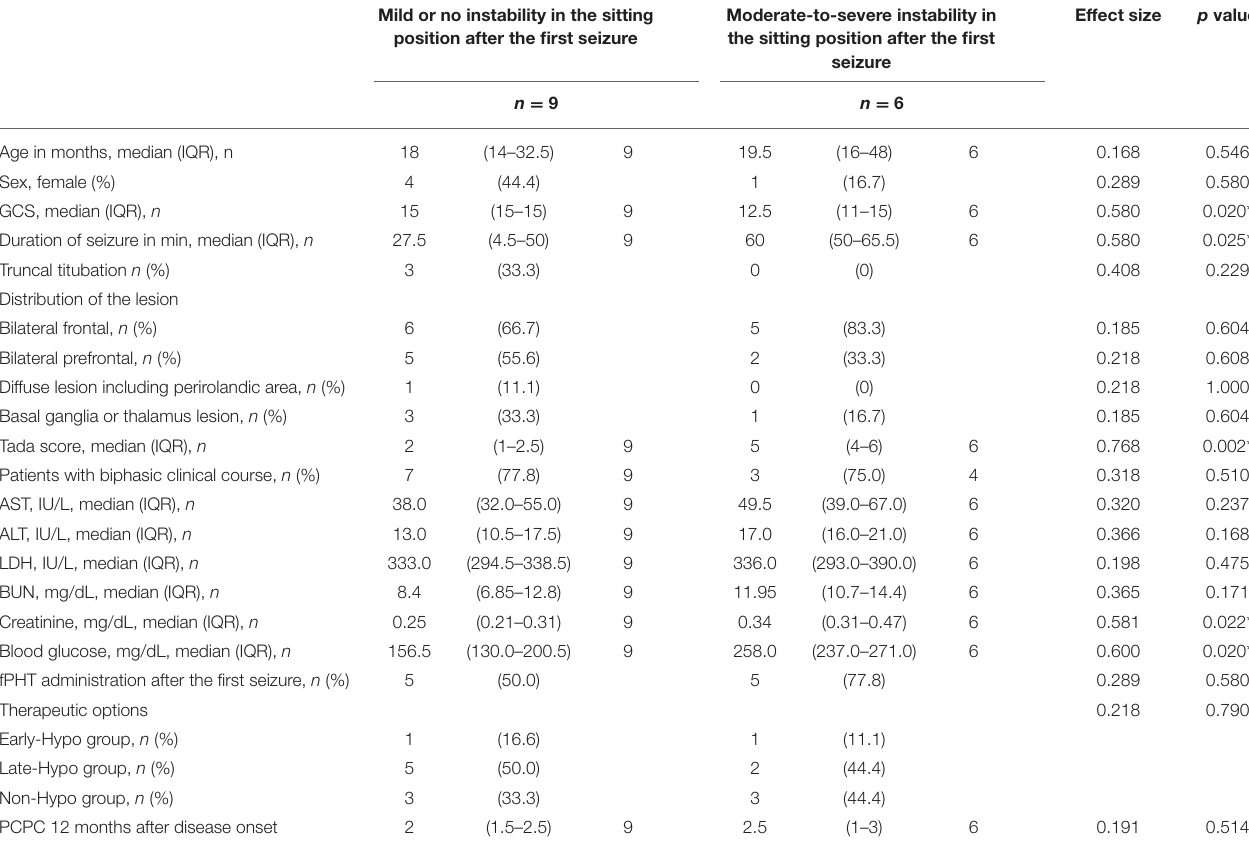
TABLE 3 | Comparison of the clinical features of patients without and with moderate-to-severe instability in the sitting position after the first seizure.